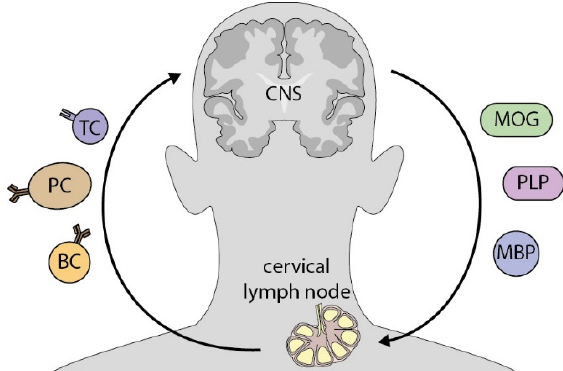
Figure 2. CNS antigens potentially activate peripheral immune cells in CNS-draining lymph nodes. Cerebrospinal fluid, which occasionally contains CNS antigen, such as myelin components, is drained by lymphatic vessels into deep cervical lymph nodes. There, antigen is encountered and processed by professional APC and subsequently presented to autoreactive antigen-specific T cells. By this interaction, immune cells are activated and in turn, migrate to the CNS, where they contribute to inflammation. Definitions: MOG = myelin oligodendrocyte glycoprotein; PLP = proteolipid-Protein 1; MBP = myelin basic protein; TC = T cell, PC = plasma cell; BC = B cell.